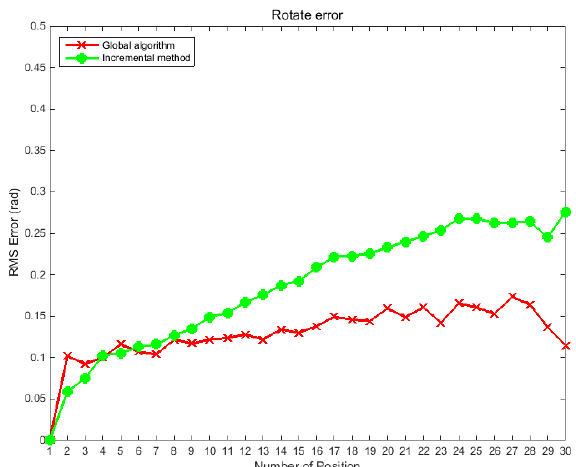
Figure 5. RMS error curves of rotation angle at different positions before and after global optimization.